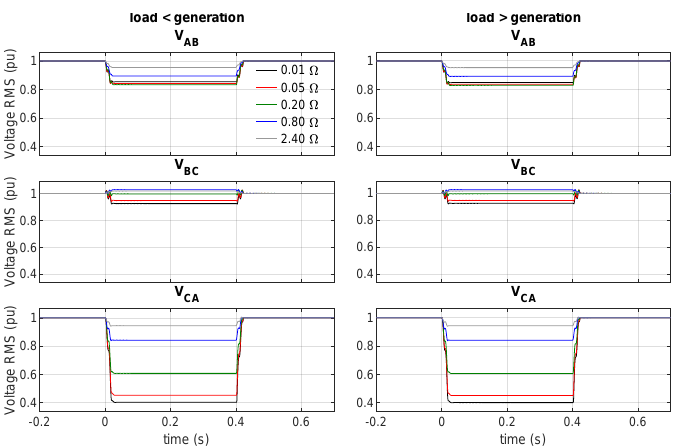
Figure 24. Phase–phase voltages at ST’s MV Inverter (AC side) following unbalanced phase-ground faults in the HV AC grid for the considered fault